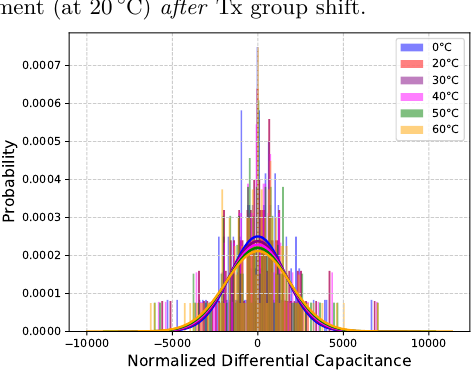
(e) Distribution of the differential capacitance (f) Distribution of the differential capacitance (with Gaussian fit) for temperatures between 0 ◦ C (with Gaussian fit) for temperatures between 0 ◦ C and 60 ◦ C before Tx group shift. and 60 ◦ C after Tx group shift. Figure 5: Analysis of the differential capacitance under temperature